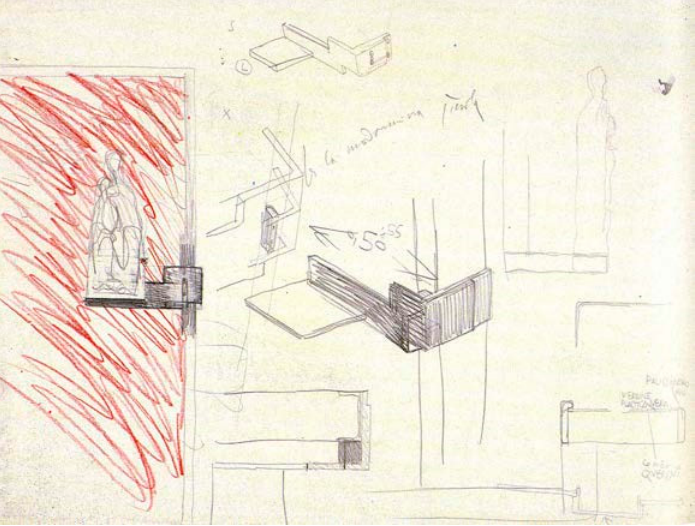
Figure 3. Carlo Scarpa, Sketch for Castelvecchio, 1962–1964.